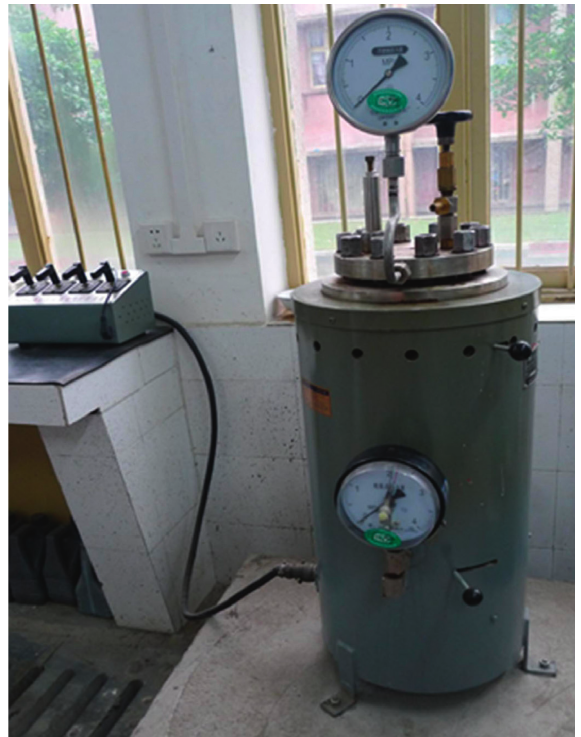
Figure 2: Autoclave kettle.